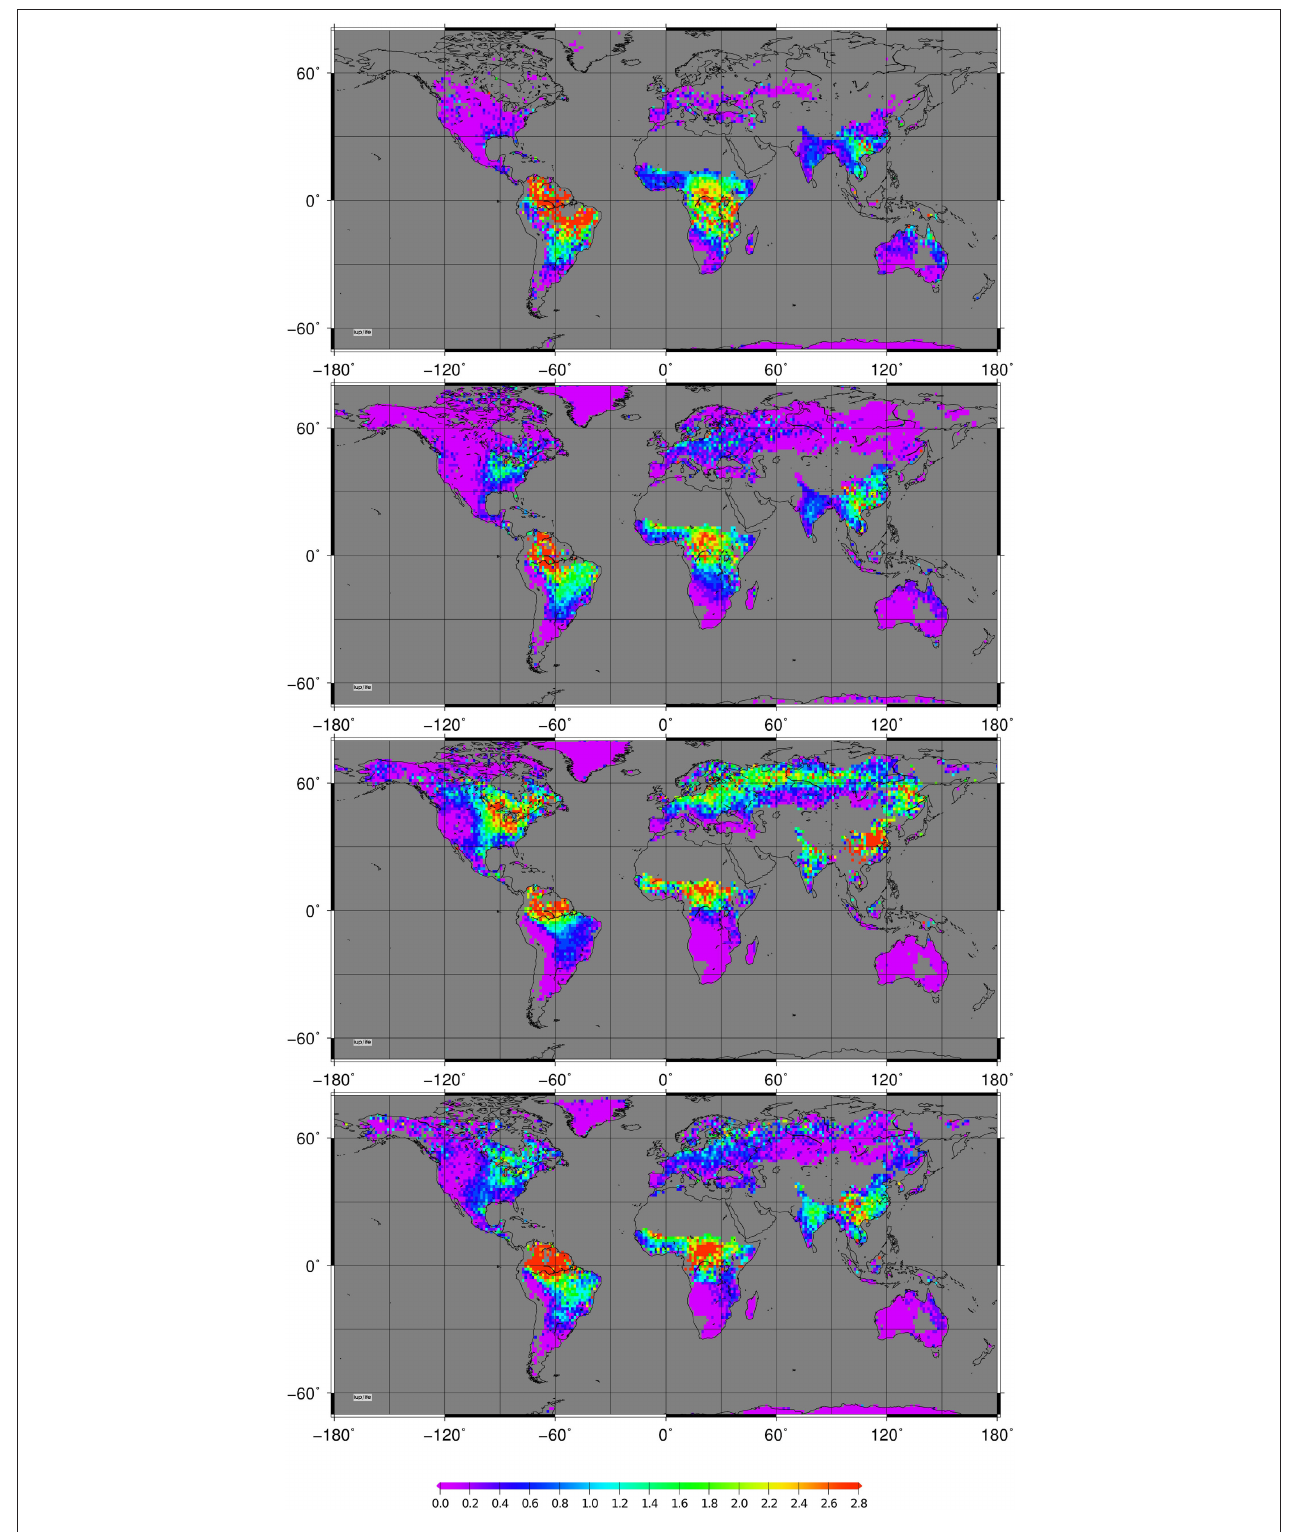
FIGURE 6 | Global values of fluorescent emission strength in [mW m − 2 sr − 1 nm − 1 ] at the top of canopy layer as seen from SCIAMACHY data. (1. upper) For Northern winter (DJF); (2. upper) For spring (MAM); (3. lower) For summer (JJA) and (bottom) For autumn (SON) months.